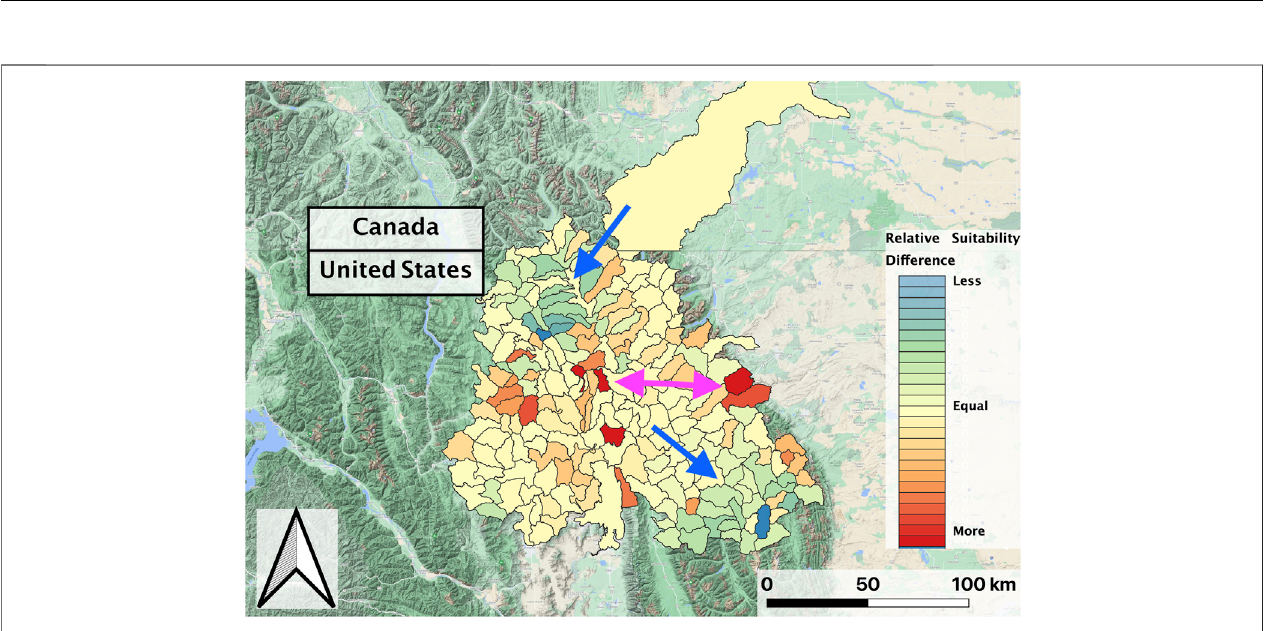
FIGURE6| NormalizedpredictedrelativeRBTsuitability changebetweenthesecond and fi rstdecadesofthestudyperiod (2002 – 2018) withintheFlatheadbasin. The Salish Mountains and Lewis Range sub-regions decreased in suitability (blue-green shades; blue arrow), while suitability marginally increased in other regions and increased more drastically in portions of the northern Mission Range and east Glacier National Park regions (red shades; pink arrow).